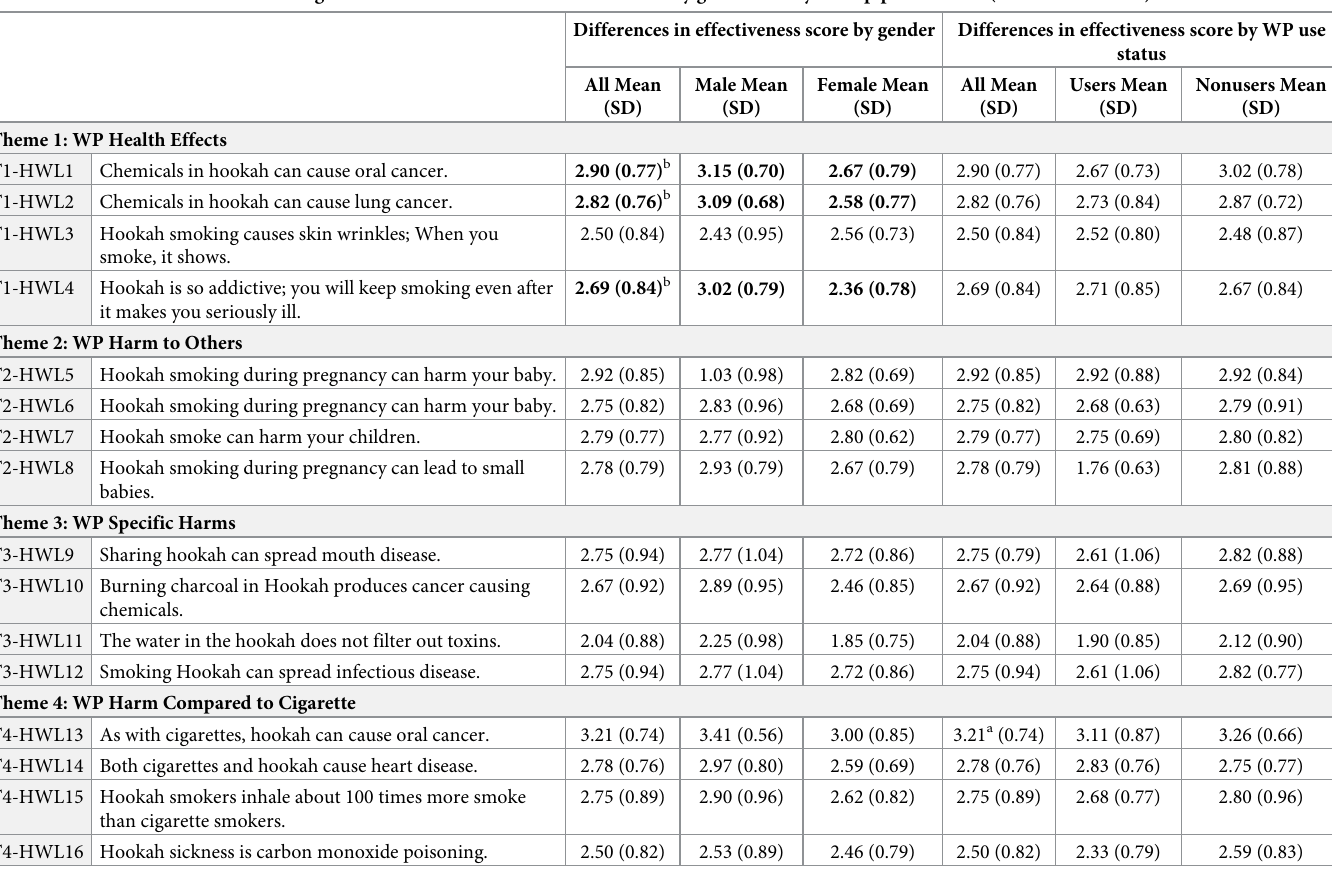
Table 3. Differences in the HWLs rating in terms of overall effectiveness stratified by gender and by waterpipe use status (users vs. nonusers). Differences in effectiveness score by gender Differences in effectiveness score by WP use